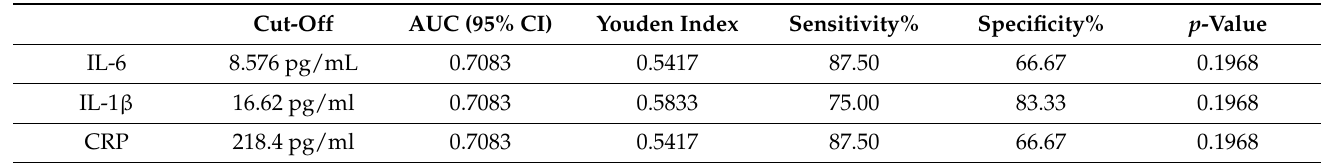
Table 5. ROC logistic regression analysis of salivary IL-6, IL-1 β , and CRP as potential diagnostic biomarkers for differentiating between children with a severe degree of PIG and those without plaque-induced gingival